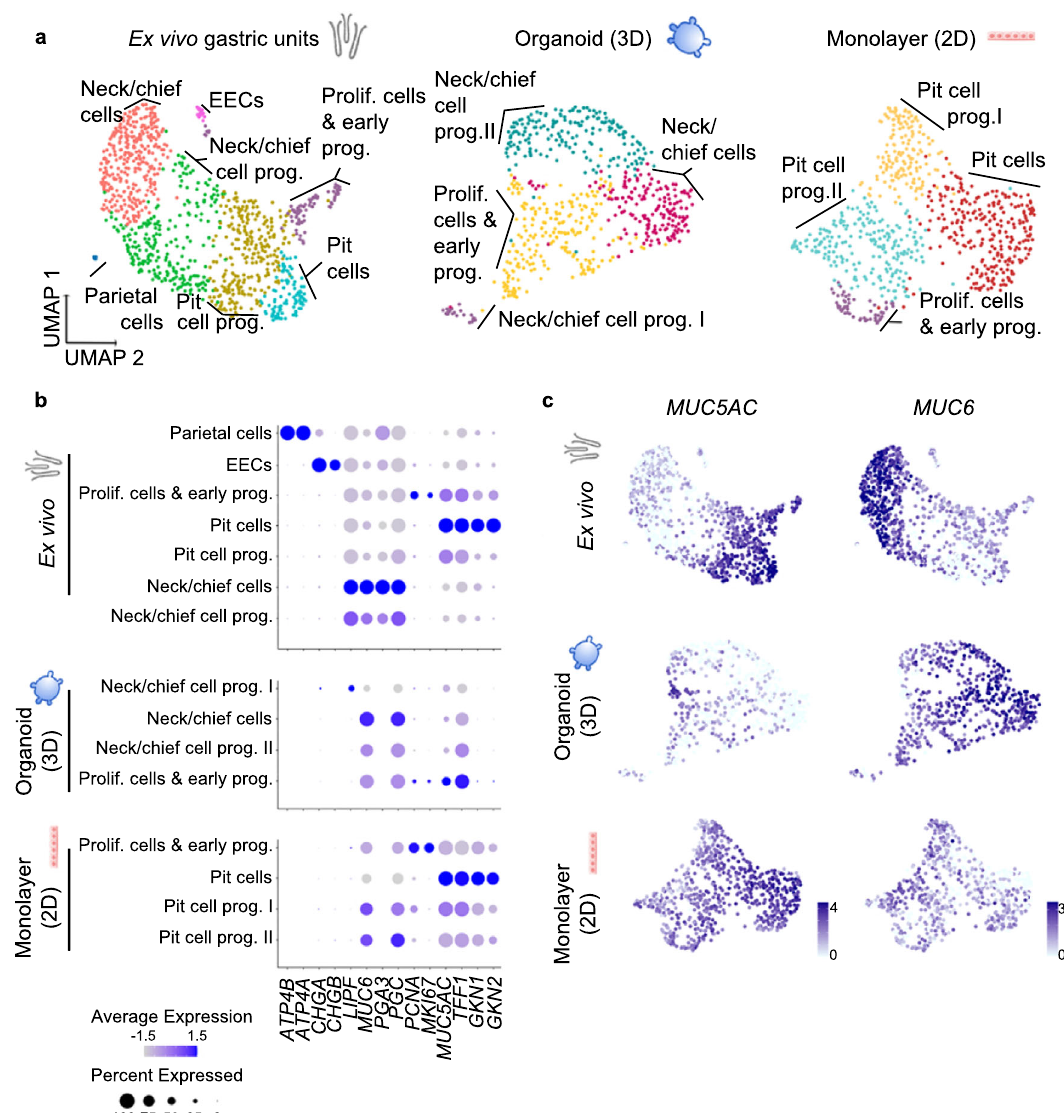
Fig. 1 | Organoids and organoid-derived monolayers represent different regionsofthegastricunits.a UMAPvisualisationsofscRNA-seqofexvivoisolated human gastric units (left, 1022 cells), gastric organoids (centre, 602 cells) and organoid-derivedmonolayers(right,696cells).EECenteroendocrinecells.Cellsare colour-coded according to the annotated clusters. b Dot plot showing the